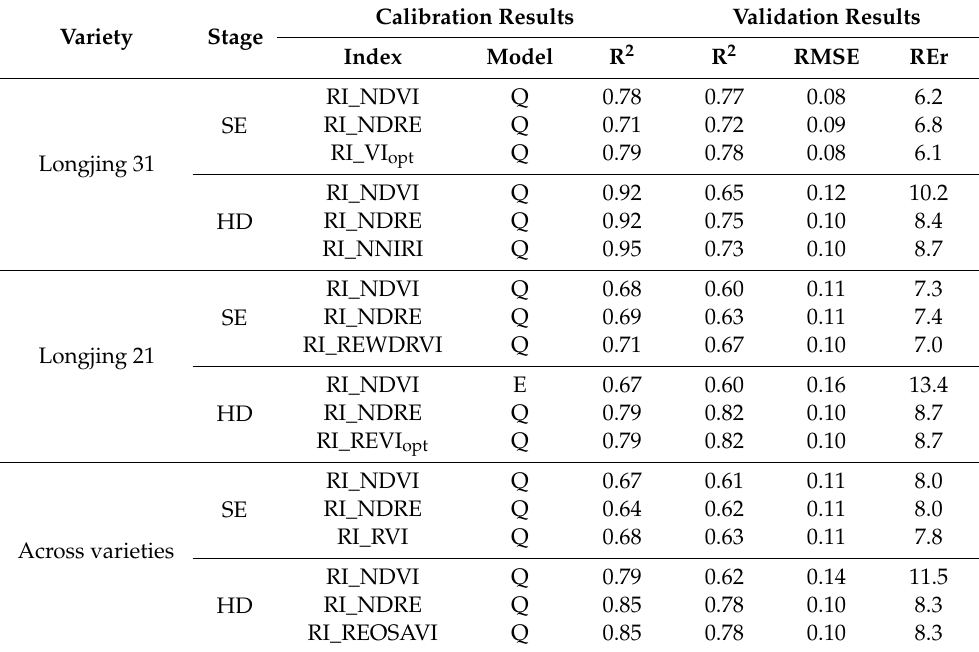
Table 5. Calibration and validation results for the response index calculated with yield (RI Harvest ) predicted by response index calculated with NDVI, NDRE, and the best performing vegetation indices for two varieties at stem elongation stage (SE) and heading stage (HD) in 2014–2016. Variety